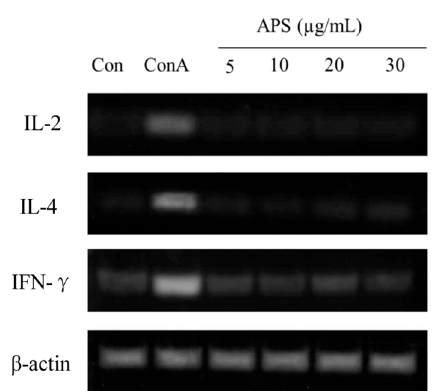
Figure 6. Cytokine expressions of IL-2, IL-4, and IFN- γ in cultured T cells for 24 h incubation with increasing APS concentrations.